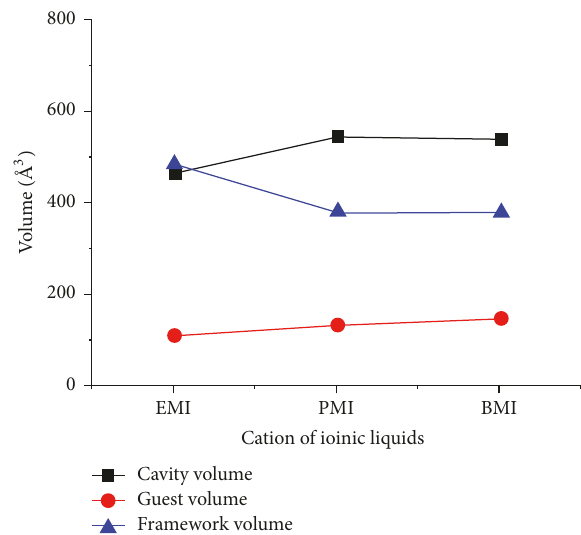
Figure 4: Plots of various calculated volumes per cation in each of the ionic liquids, where the data for guest and guest pair volume for EMI have been imported from the isoreticular correspondent prepared with nickel in place of cobalt for better illustration of the increasing trend of the